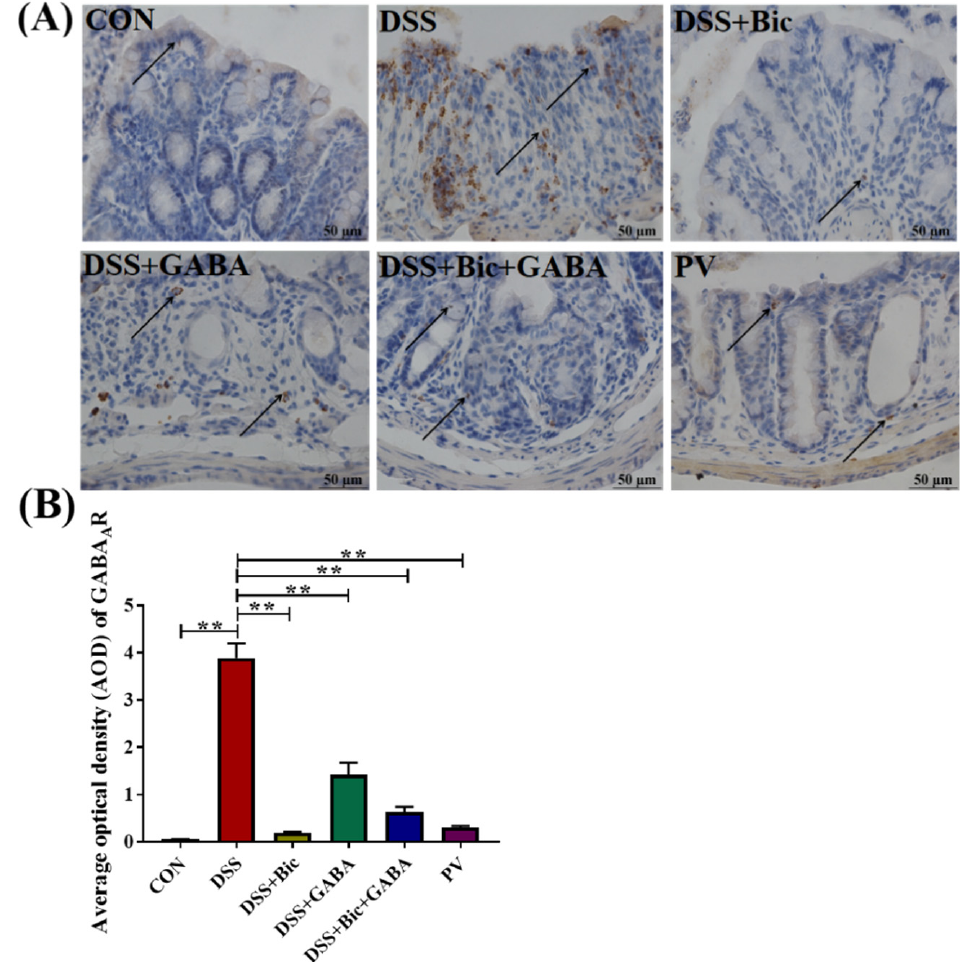
Figure 3. Evaluation of GABA A R expression in the mouse colon. ( A ) Representative immunohisto- chemistry data for GABA A R staining (brown) in the colon. Arrows point towards the GABA A R signal. ( B ) Statistical analysis of GABA A R expression. Data are presented as mean ± SEM ( n = 5 per group). ** p < 0.01 vs. the control group.